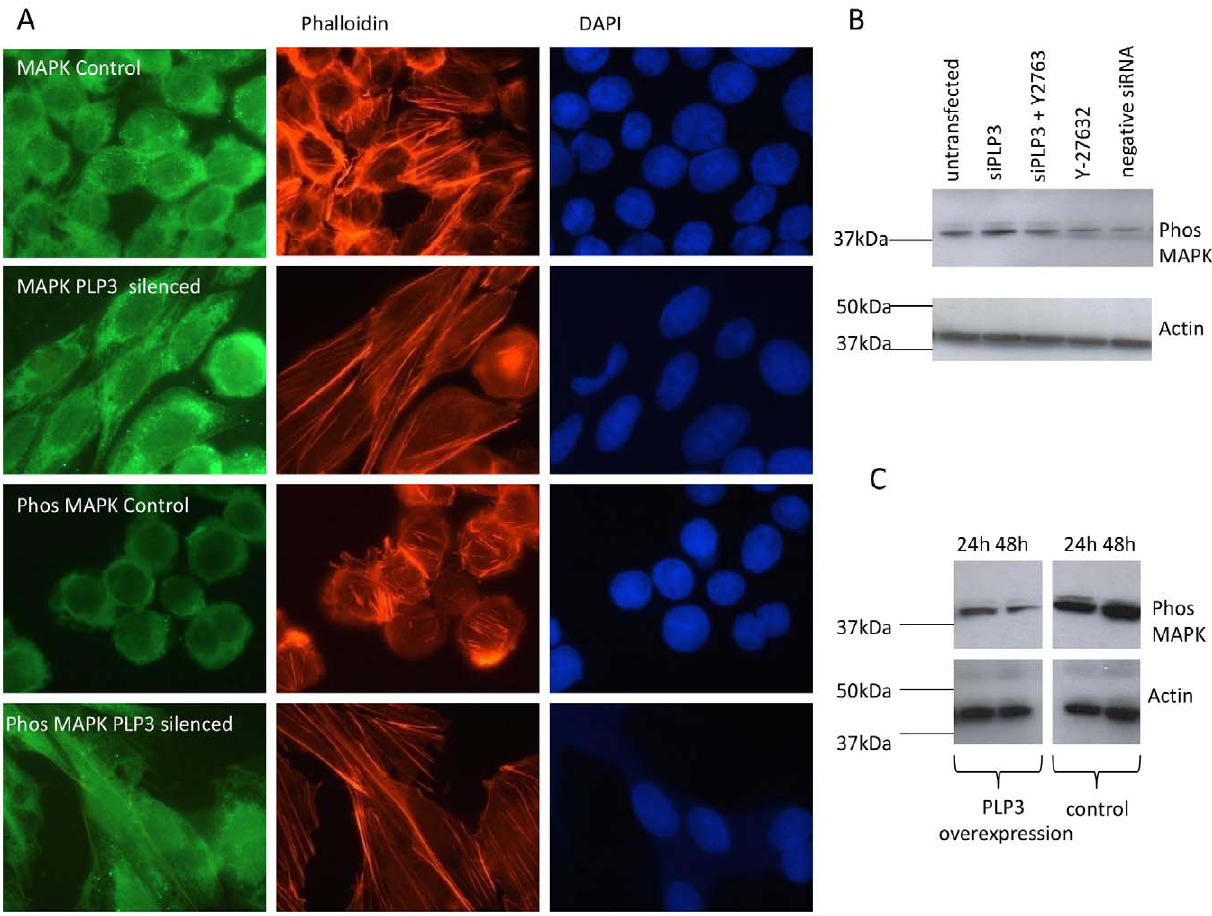
Figure 5. siRNA silencing of PhLP3 promotes MAPK phosphorylation upstream of RhoA activation and PhLP3 overexpression decreases levels of phosphorylated MAPK in suspension CHO LB01 cells. (A) PhLP3 silenced LB01 cells were fixed and co-stained with either anti-MAPK (second panel, green) and rhodamine phalloidin (for filamentous actin, red) or anti-phosphorylated MAPK (fourth panel, green) and rhodamine phalloidin. DAPI was used to detect DNA. Untransfected cells were used as controls (first and third panel). (B) An increase in phosphorylated MAPK was detected by immunoblotting using an anti-MAPK kinase antibody in cells transfected only with PhLP3 siRNA (lane 2) compared to cells that had been transfected with PhLP3 siRNA in the presence of the ROCK inhibitor Y2763 (lane 3). Cells treated with either Y2763 only, cells transfected with a ‘scrambled’ negative control siRNA and untransfected cells did not show elevated phosphorylated MAPK levels. (C) CHO cells were transiently transfected with PhLP3 for either 24 h or 48 h and levels of phosphorylated MAPK were detected by immunoblotting with an anti-MAPK kinase antibody. Expression levels of phosphorylated MAPK were found to decrease from 24 h to 48 h (compare lanes 1 to 2) and to be lower than in untransfected cells (lanes 3 and